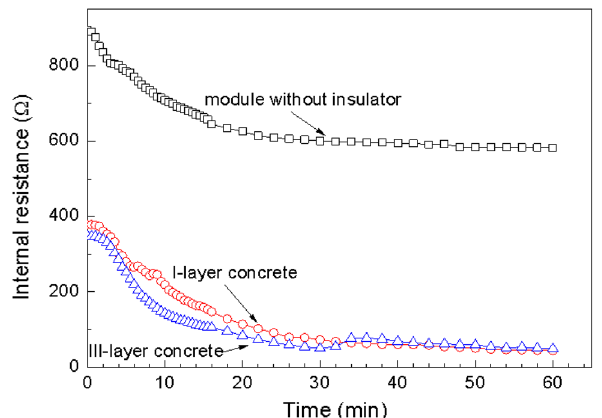
Figure 12. Internal resistance of the TEG module without a thermal insulator and the thermoelectric concrete brick of the I-layer and III-layer bricks as a function of